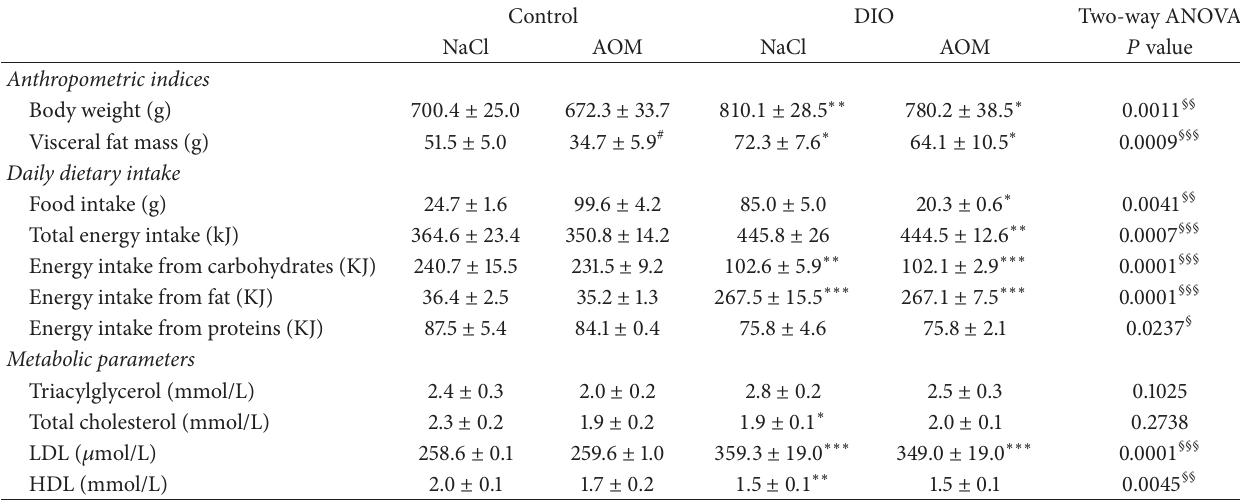
Table 2: Anthropometric, nutritional, and metabolic data in normal weight (control) or diet-induced obese (DIO) rats treated with NaCl or azoxymethane (AOM).